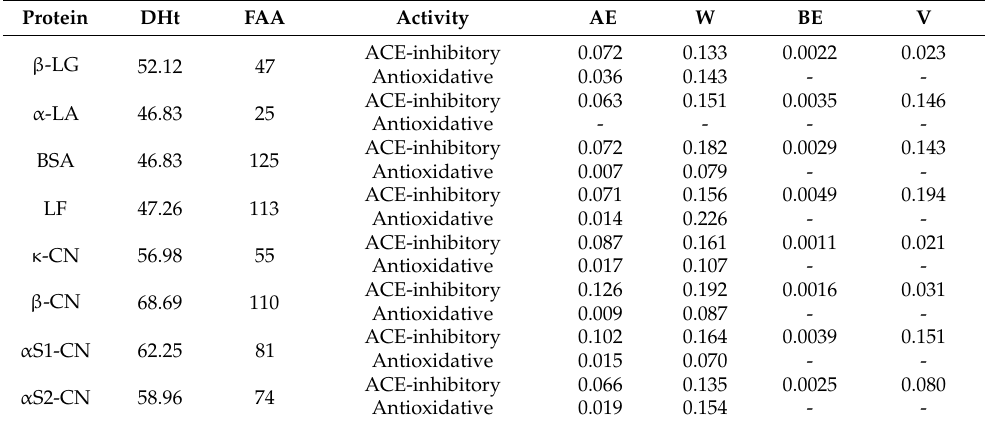
Table 4. Results of bioinformatic modeling of the hydrolysis of milk whey proteins by the